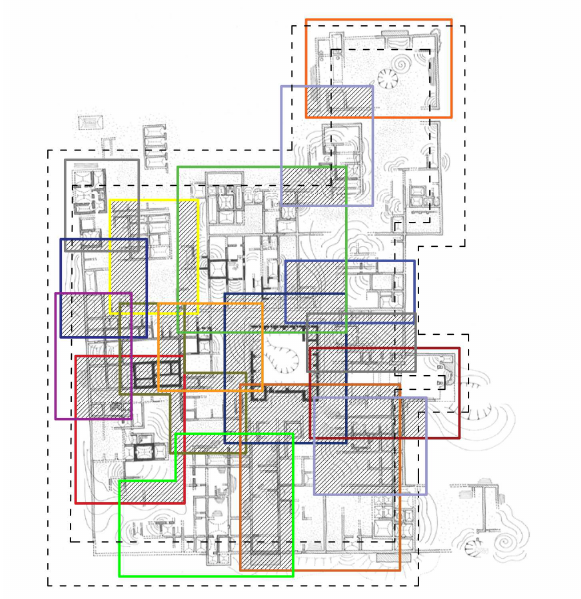
Figure 3: The subdivision of the area in the 18 sub/areas. The hatched parts are the main overlap among the different image